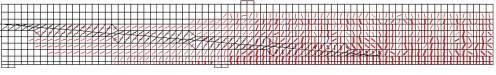
Figure 14: Crack pattern of beam at